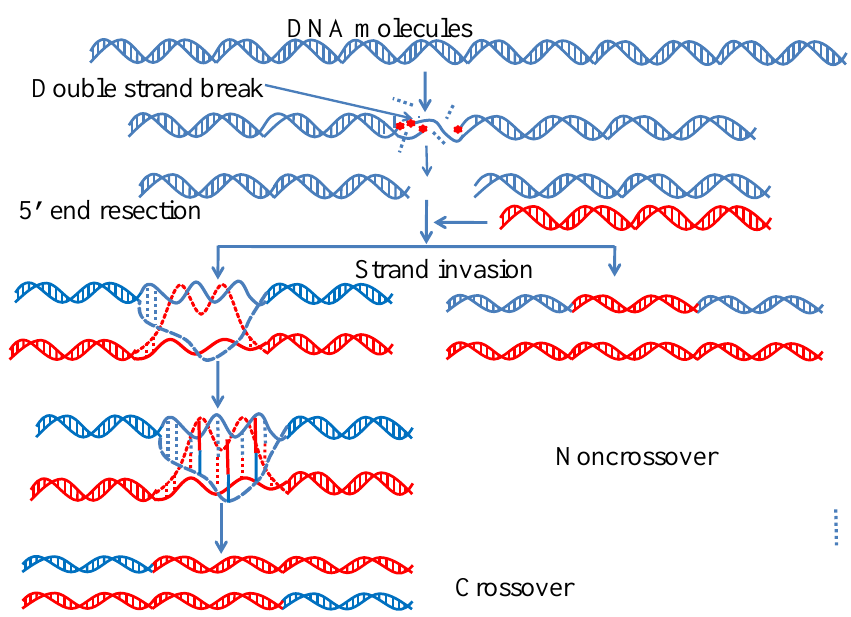
Figure 1. An illustration to show the process of meiosis and recombination in a DNA system. Adapted from